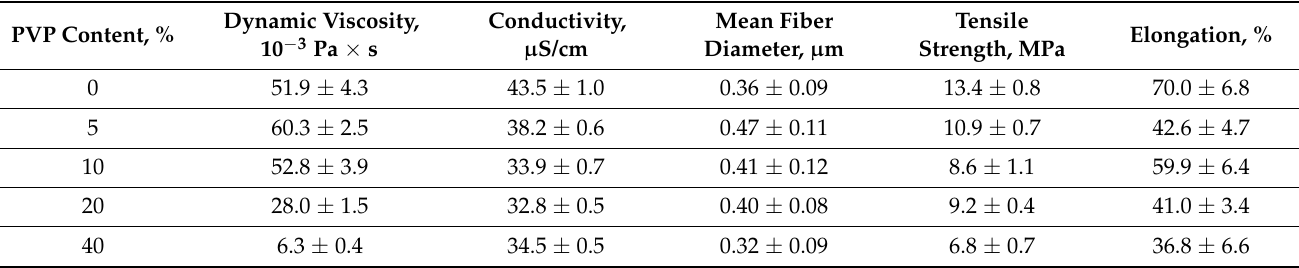
Table 1. Spinning solution viscosity and average fiber diameter, tensile strength, and elongation of the fabricated materials with various PVP contents.